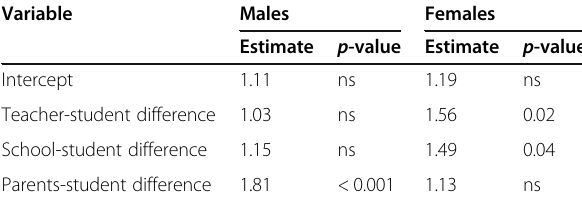
Table 4 Odd-ratio results for logistic regression